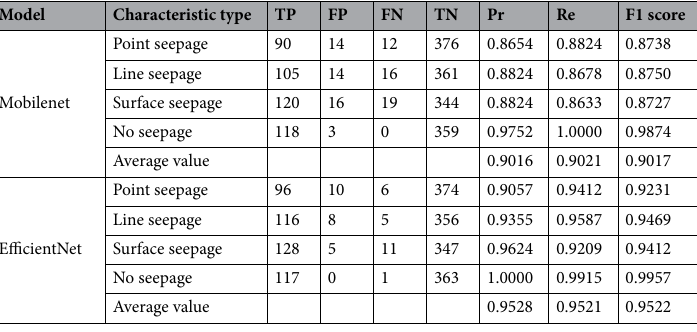
Table 3. Statistics table of water seepage prediction